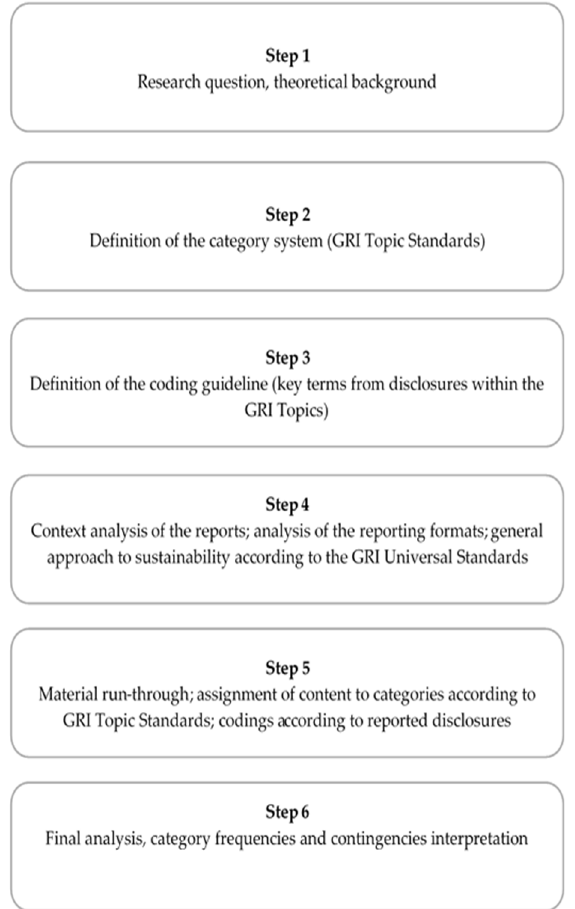
Figure 4. Structuring analysis of the content scope of airline sustainability reporting (authors’ own figure).